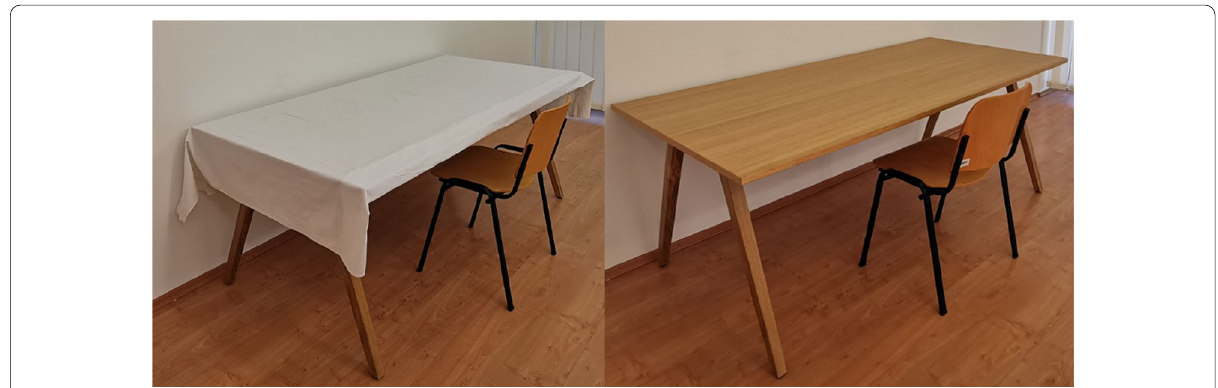
Fig. 1 The test desk in the control (left) and experimental condition